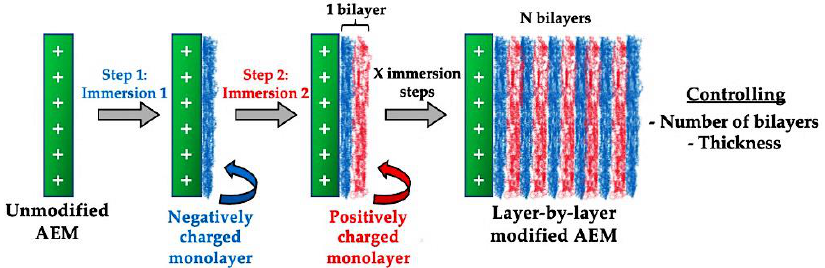
Figure 5. Graphical representation of a layer-by-layer (LbL) strategy via vertical membrane immersion, in which X stands for the number of consecutive immersion steps.